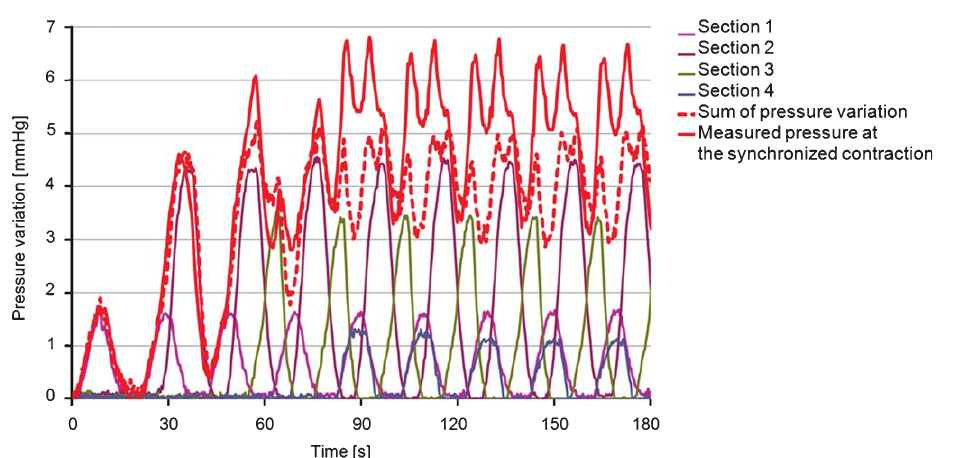
Fig. 10. The measured pressure variations of each section, the sum of pressure variations (calculated), and the measured pressure at the synchronized contraction. tion, the wall needs to be thick enough to restore